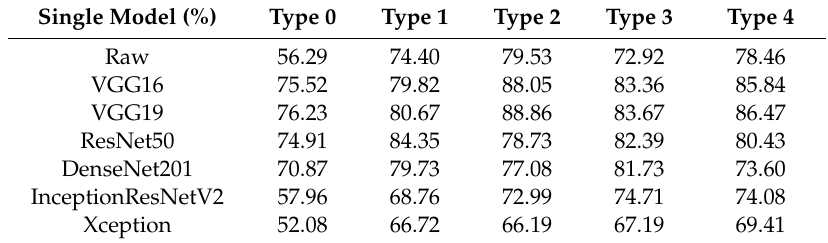
Table 5. Classification performance of the CNNs without data augmentation under transfer learning (5 classes).